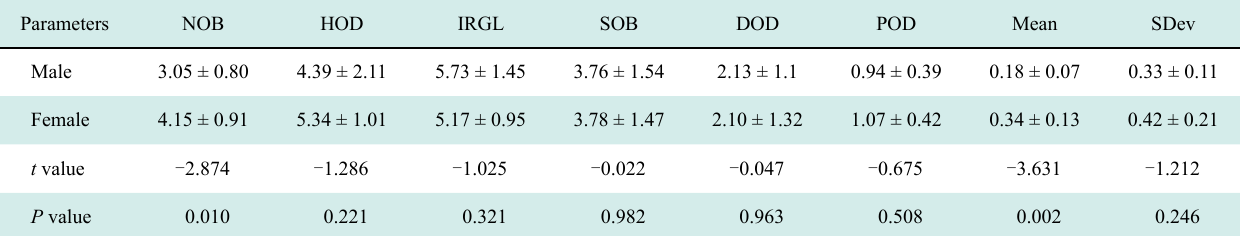
NOB, number of blobs of texture density; HOD, homogeneity of distribution of texture uniformity; IRGL, irregularity of texture primitive shape; SOB, mean size of blobs of texture primitive; DOD, directionality of texture distribution; POD, periodicity of texture distribution; Mean, Mean of texture gray scale; SDev, standard variance of gray